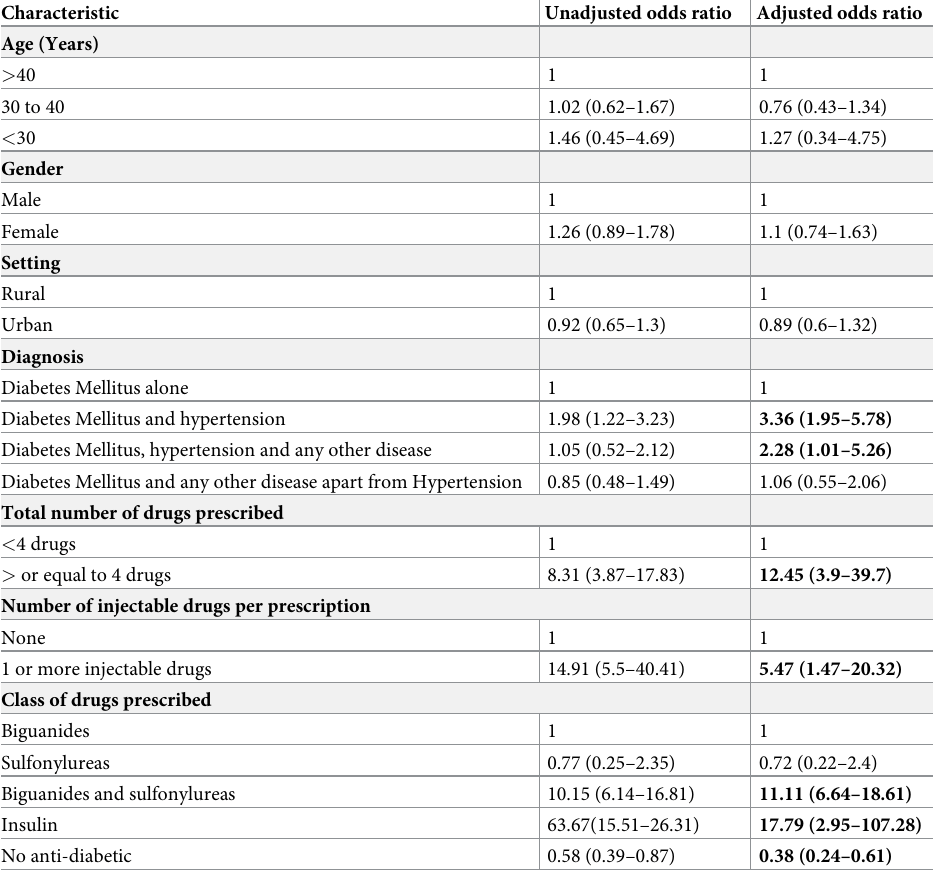
Table 2. Predictors for non-affordability of medicines prescribed for diabetic